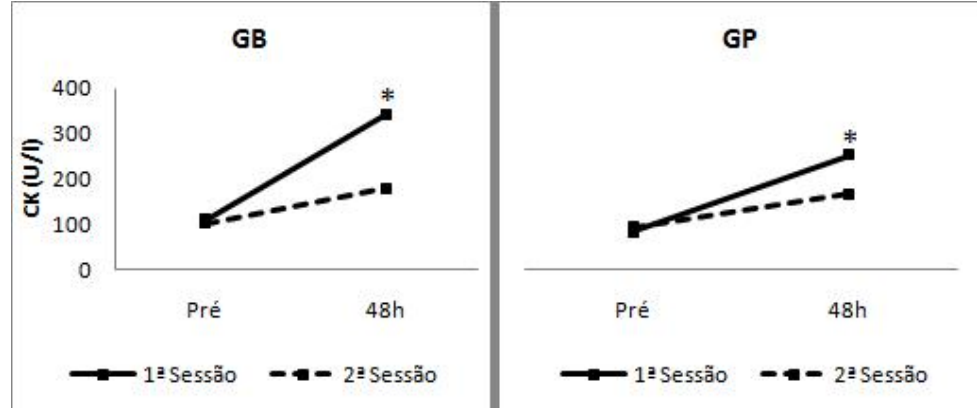
Figura 2. Mudanças na atividade sérica de CK antes e 48 horas após as 2 sessões de EEM para os grupos GB e GP. Os asteriscos (*) indicam diferença significativa (p<0,05) em relação à condição basal da respectiva